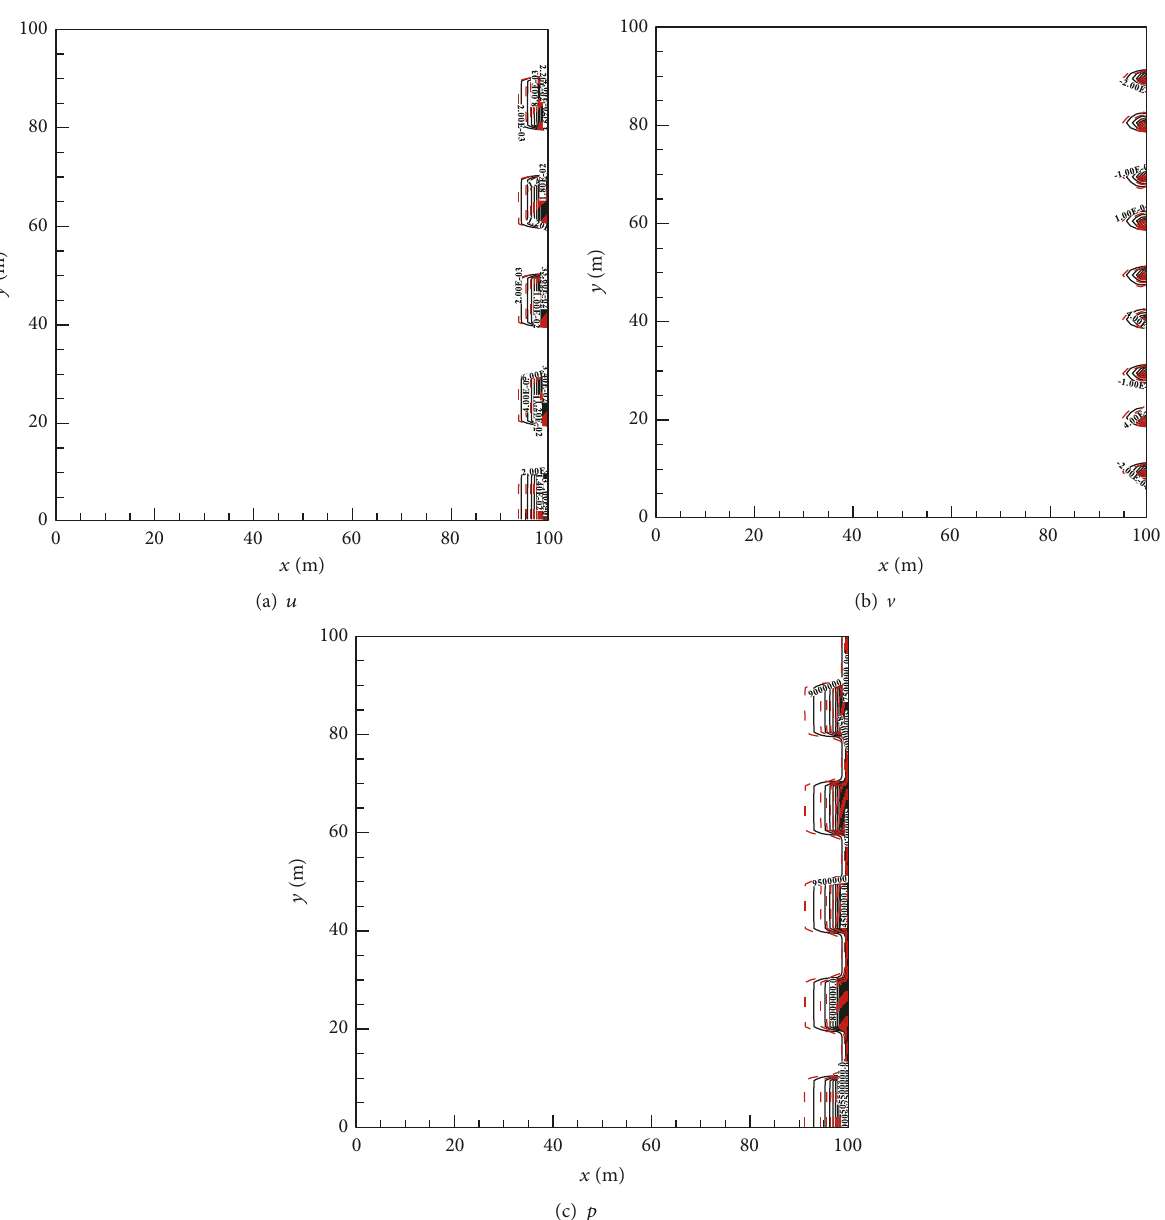
1.95 × 10 −3 % ∼ 6.55% for real gas. The acceleration ratio is